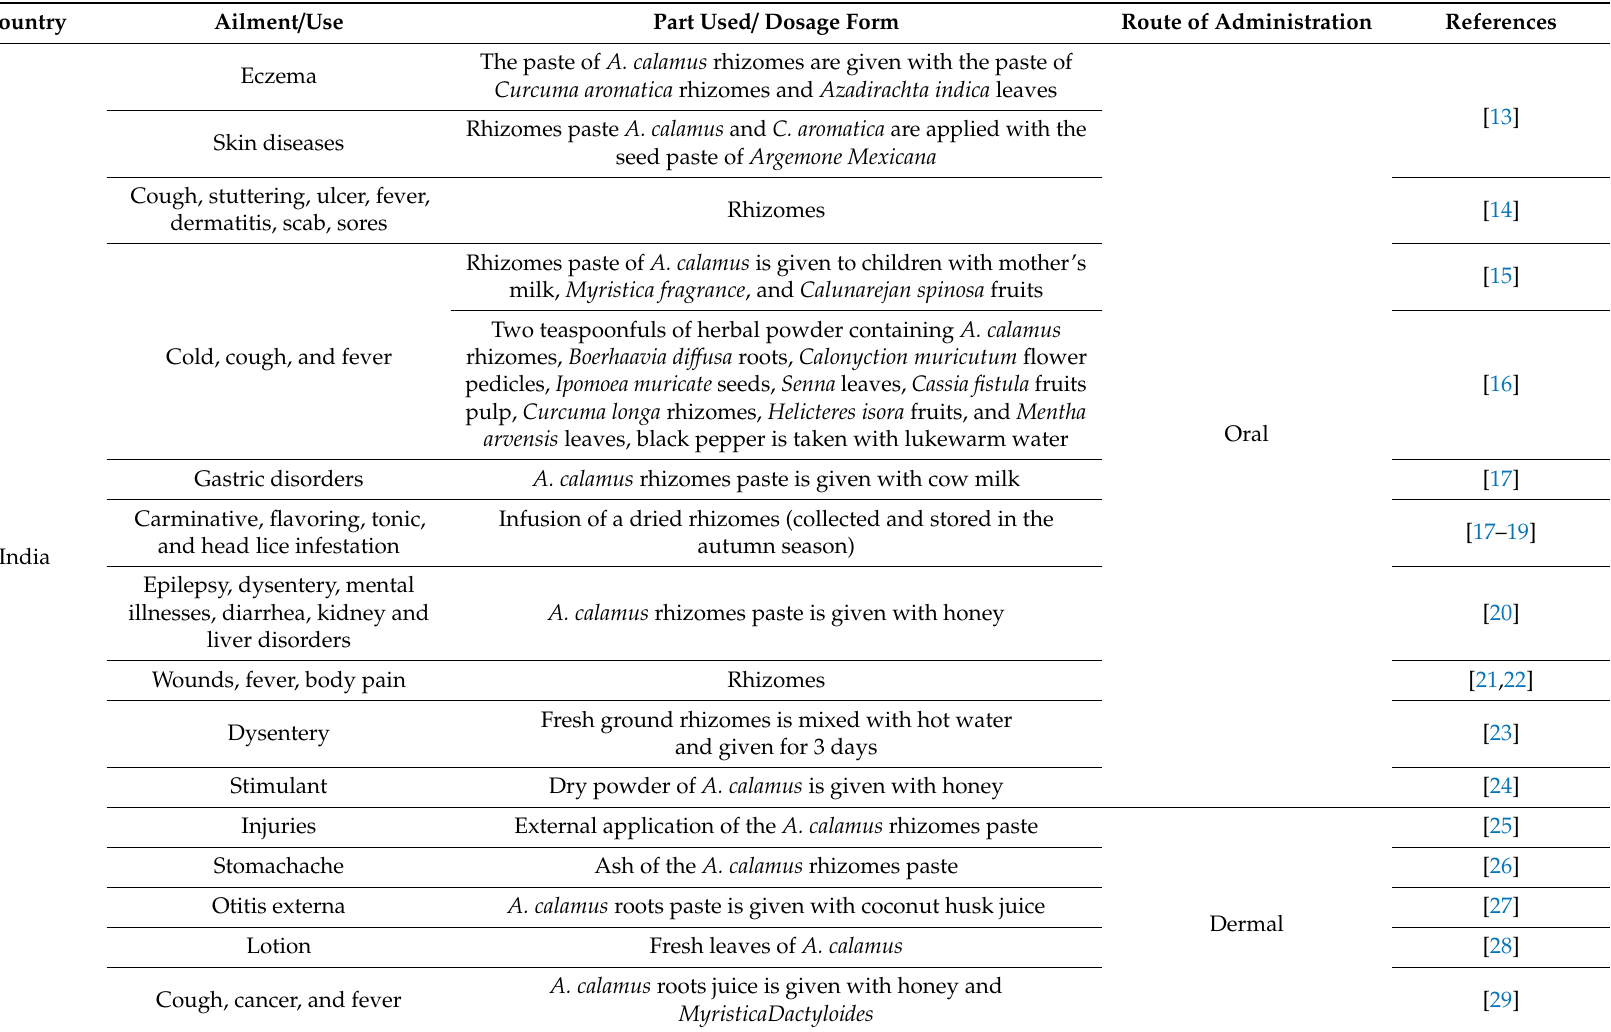
Table 1. Ethnomedicinal use of A. calamus in various